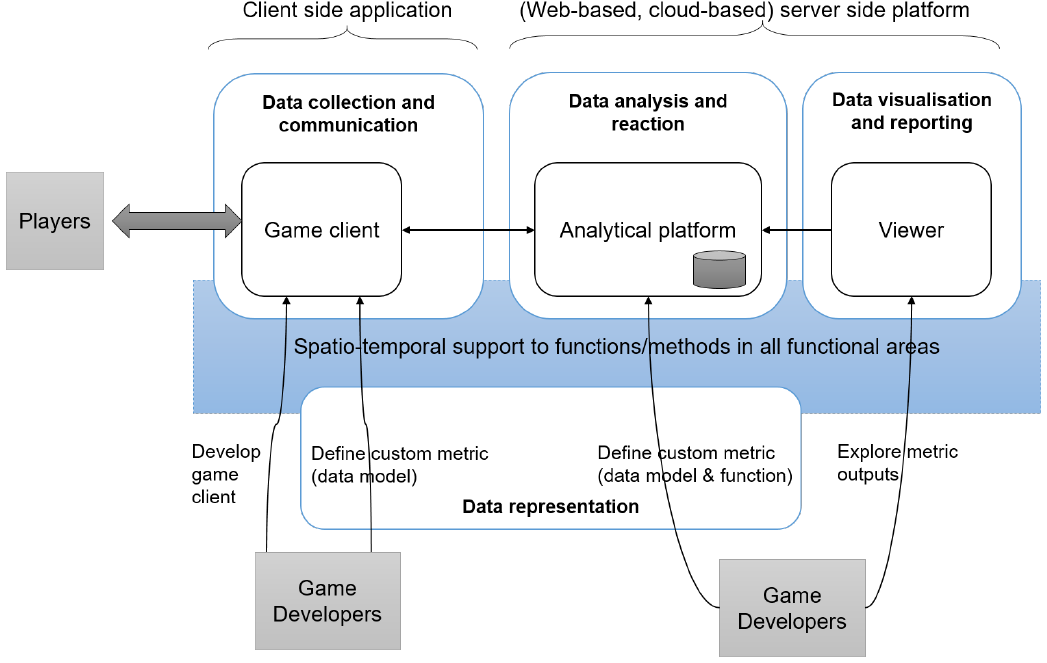
Figure 1. Schematic architecture for (location-aware) games analytical platforms and